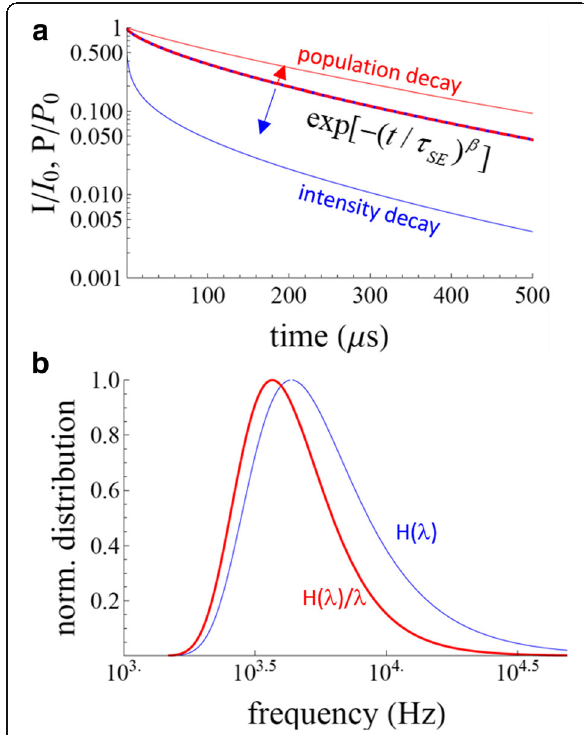
Fig. 1 Stretched exponentials. a Population and intensity decays for the stretched exponential function with τ SE = 100 μ s and β = 0.7. The blue-red dashed line is exp[ − ( λ t ) β ]. If this represents the population decay, then the intensity decay will be given by the blue line. If exp[ − ( λ t ) β ] is the intensity decay, then the population decay is shown with the red line. b The corresponding rate